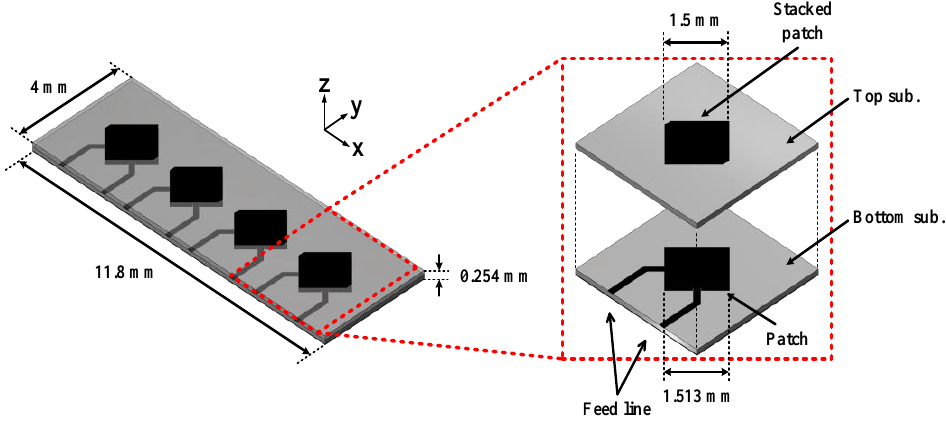
Figure 9. Geometry of the proposed 1 × 4 patch array antenna.